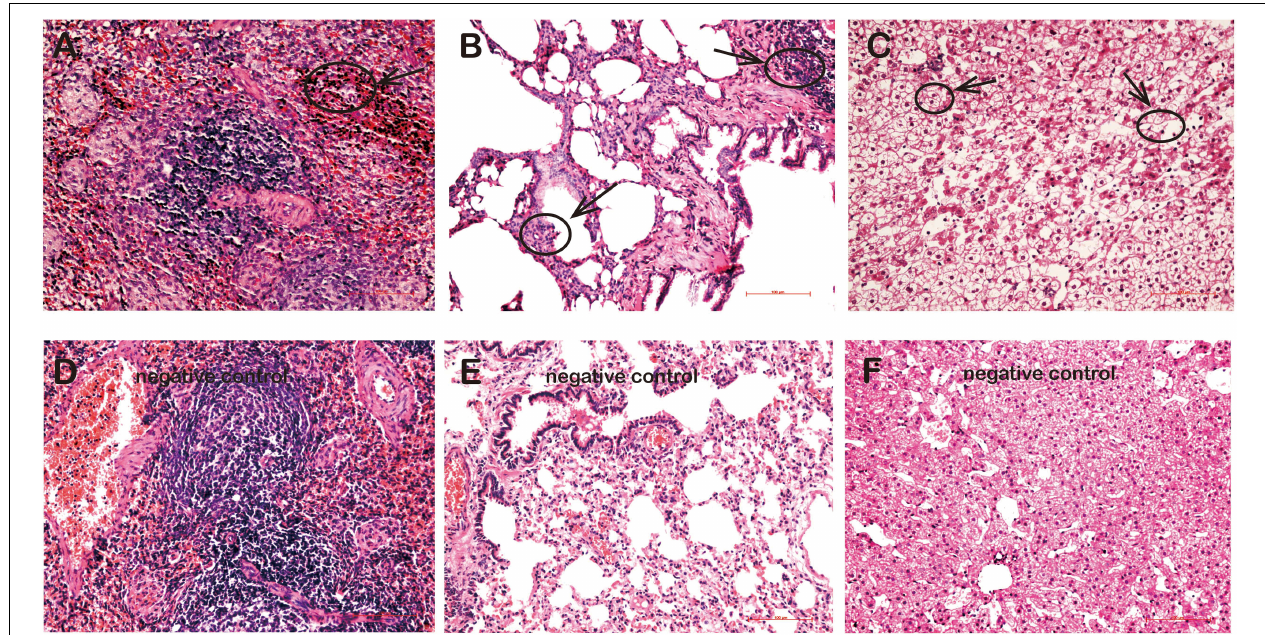
FIGURE 5 | Pathological changes in the tissues of rKSHV.219-infected tree shrews. (A) Inflammatory cell infiltration and hyperplasia in the spleen of TS3 at 119 dpi. (B) Extensive inflammatory lymphocyte infiltration and alveolar wall hyperplasia in the lung of TS7 at 56 dpi. (C) Hepatic edema and hepatic sinus expansion in the liver of TS3 at 119 dpi. Panels (D–F) were negative control of spleen, lung, and liver, respectively. Original magnification, 20 × .